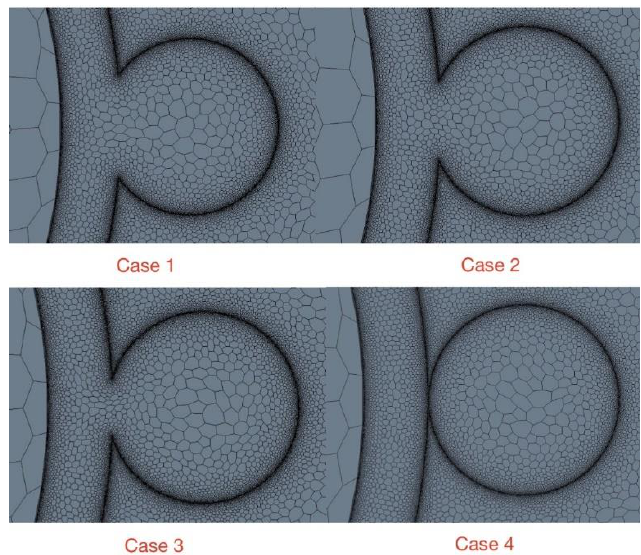
Figure 19. Four embedding depths.